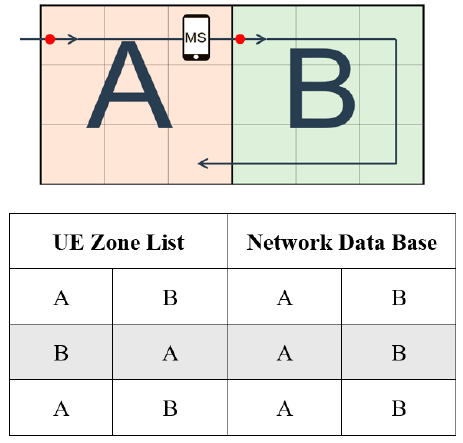
Figure 2. Location registration in 2ZR.